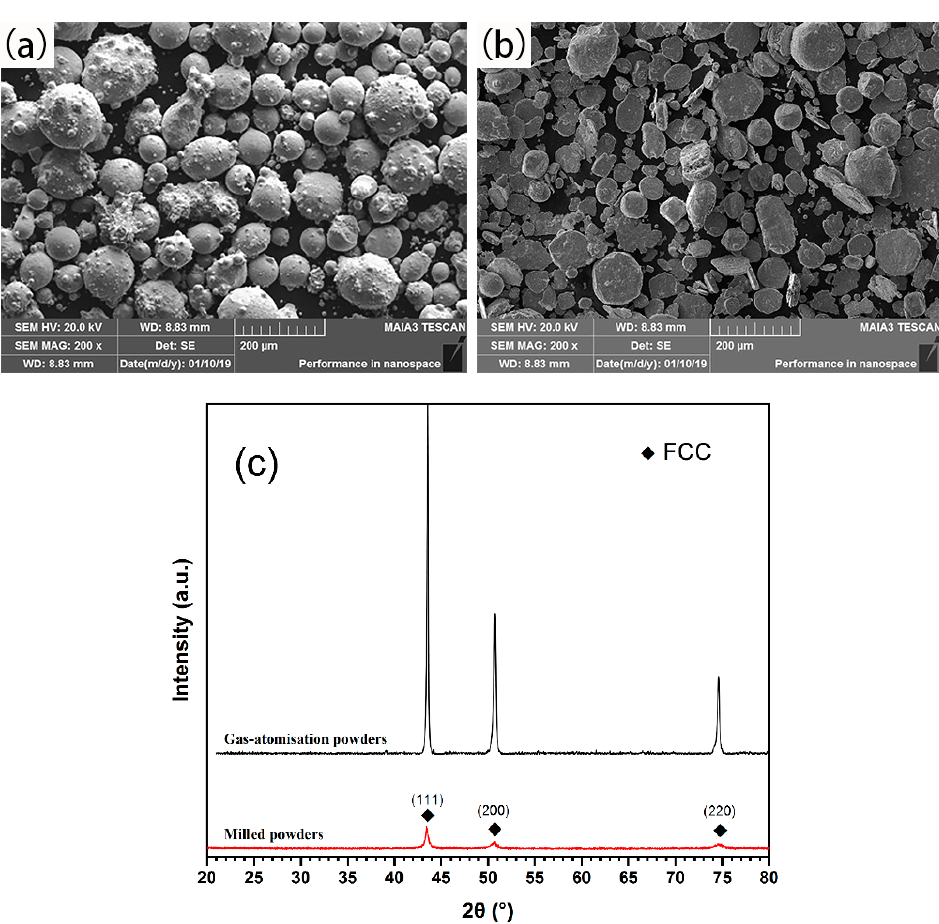
Figure 1. Microstructure of FeCoCrNiMo high-entropy alloy (HEA) powders before ( a ) and after ( b ) ball milling, ( c ) X-ray diffractometer (XRD) pattern of two powders. FCC—face-centered cubic.